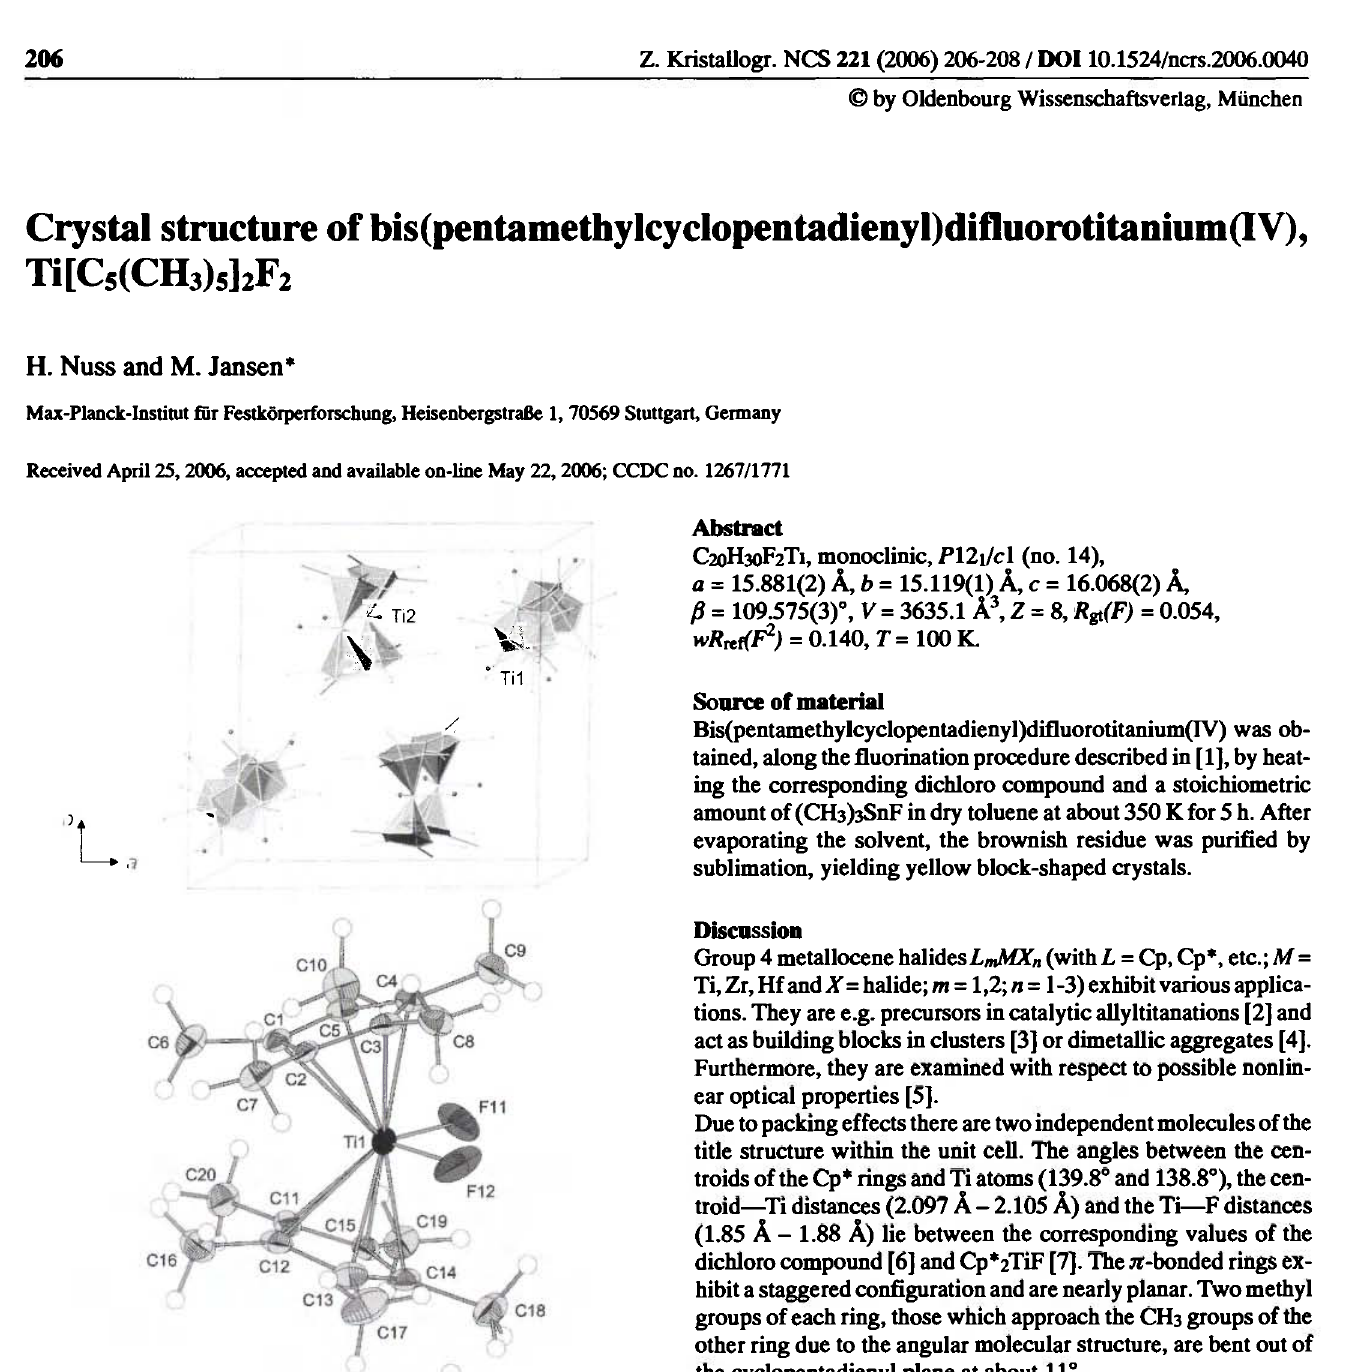
Table 1. Data collection and